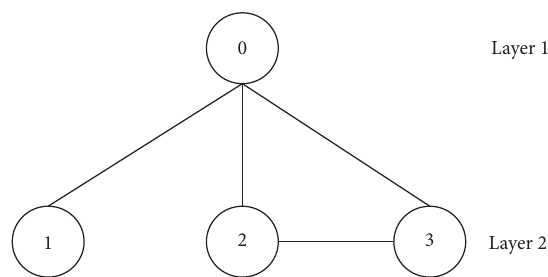
Figure 3: The directed graph of the three-component system.